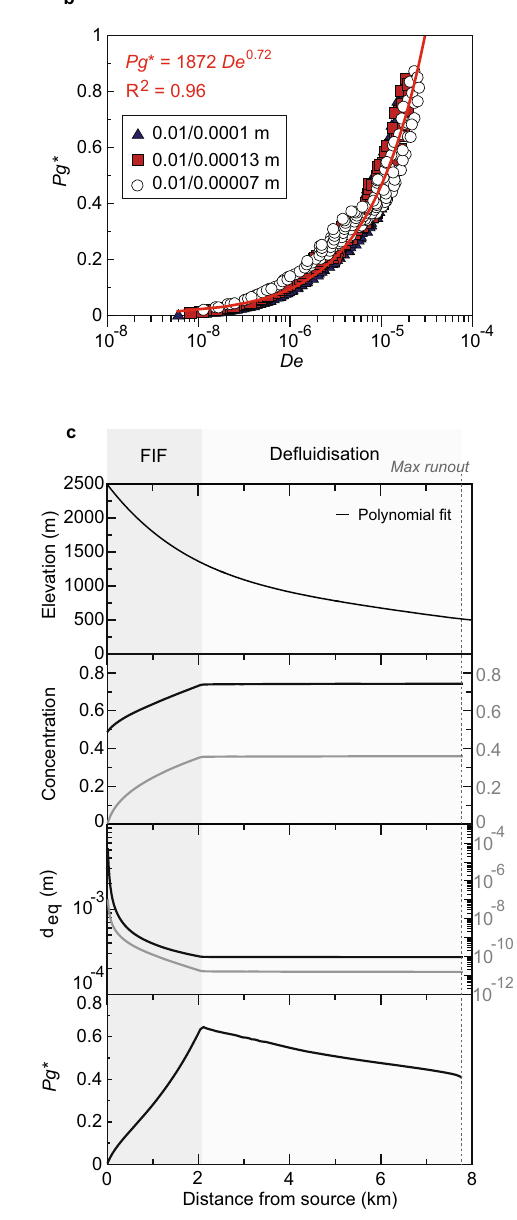
Fig. 3 | Multiphase modelling of compressible granular media. a Maximum excess pore pressure generated Pg* (Pg*=pore pressure/lithostatic pressure) as function of fl ow heightand ash generation rates (fragmentationrate) in a static2D column. b Scaling of Pg* with the Deborah (De) number. 193 simulations were run for each bidisperse distribution (10 − 2 m and 10 − 4 m; 10 − 2 m and 1.3 × 10 − 4 m; 10 − 2 m and 7 × 10 − 5 m). A best fi t is presented (red line). c Numerical simulation results illustratingtheevolutionofa18mthickbed(at t =0s),undergoingafragmentation rate of 25kgm − 3 s − 1 . The mixture propagates along the Gendol Valley at Merapi volcano (Indonesia). The solid concentration, equivalent diameter, permeability